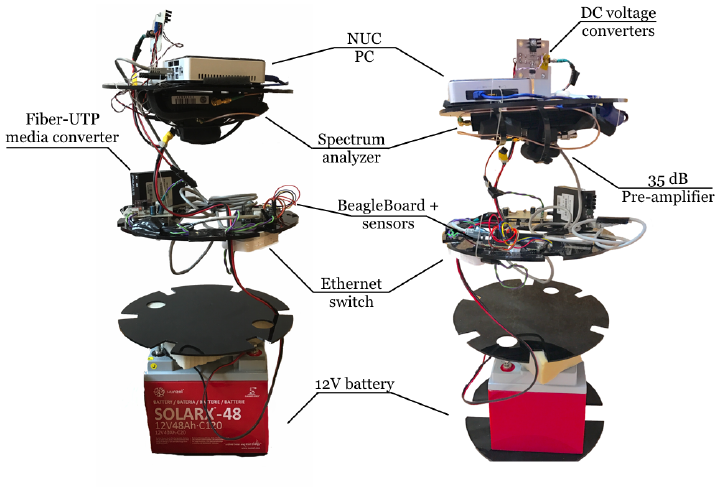
Figure 3. Receiver chamber (front and lateral view of the